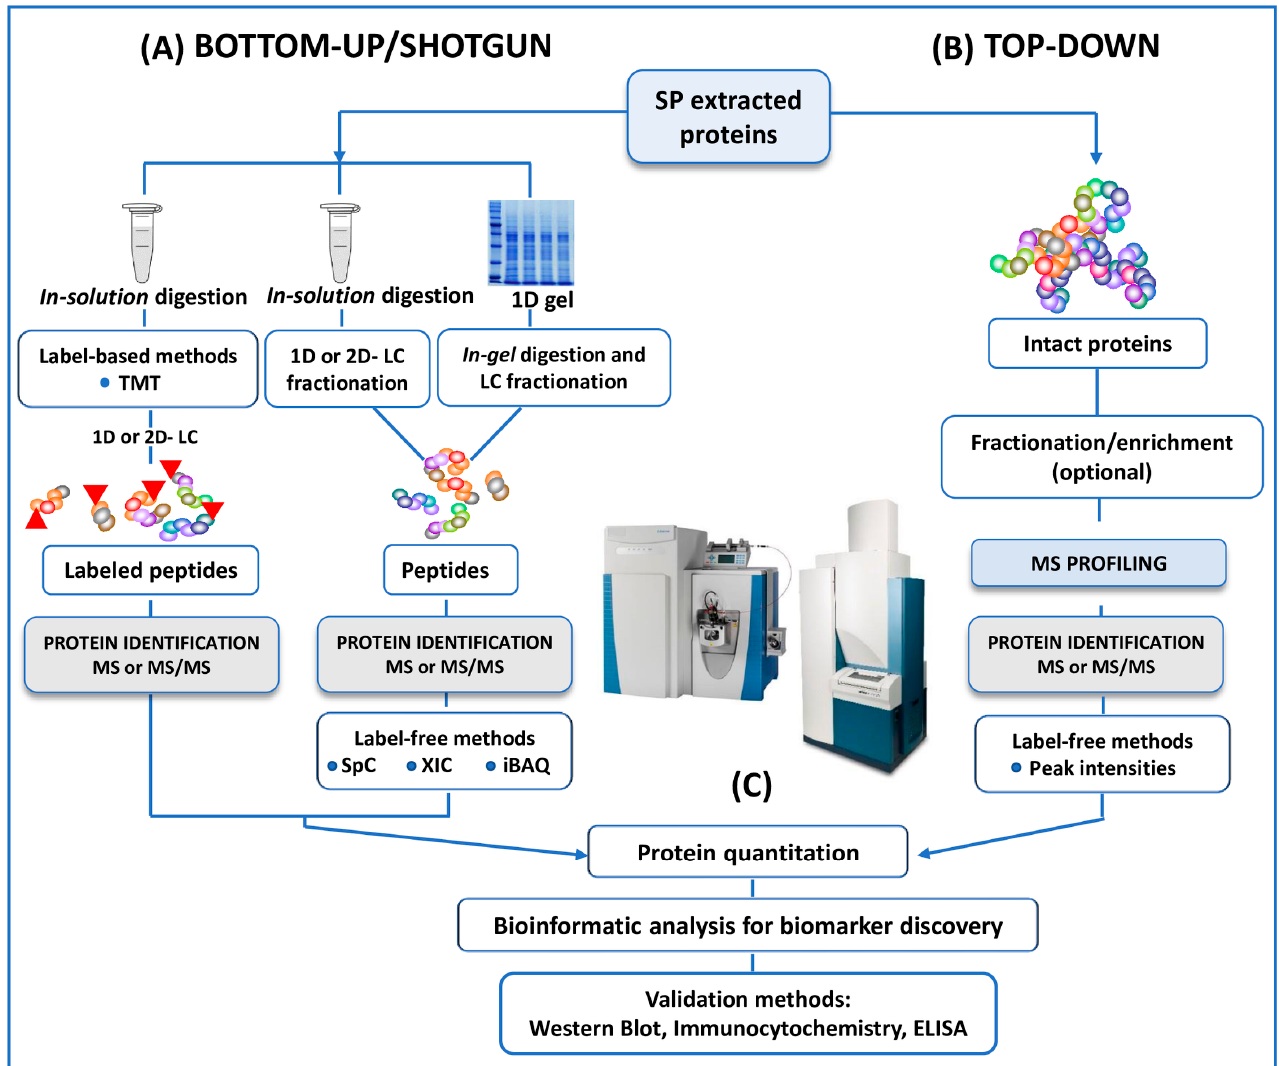
Figure 2 . A schematic outline of all the protocols here reviewed in both bottom-up and top-down untargeted MS approaches for the proteomic analysis of human SP. ( A ) In conventional bottom-up (or shotgun) strategy, proteins extracted from SP are reduced, alkylated and digested in solution.